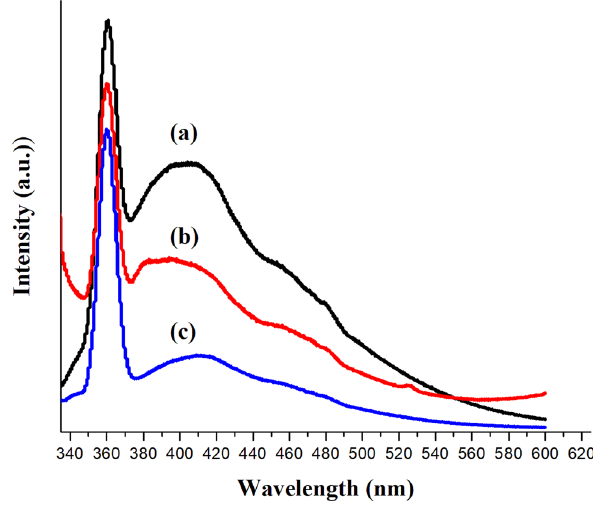
Figure 7: PLspectraof: ( a ) undopedZnO, ( b ) Fe – ZnO - 3,and ( c ) Fe – ZnO - 5.